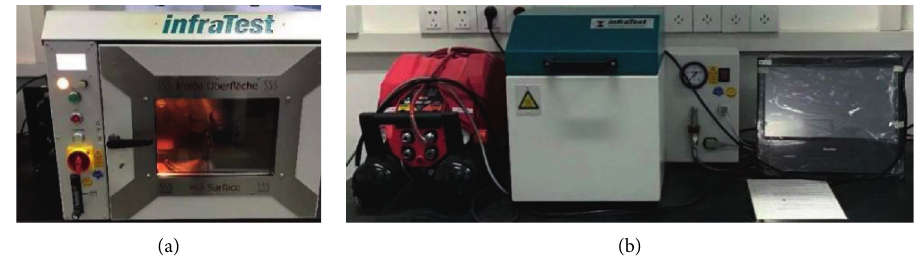
Figure 1: Aging instrument for asphalt binder. (a) RTFOT. (b) PAV.